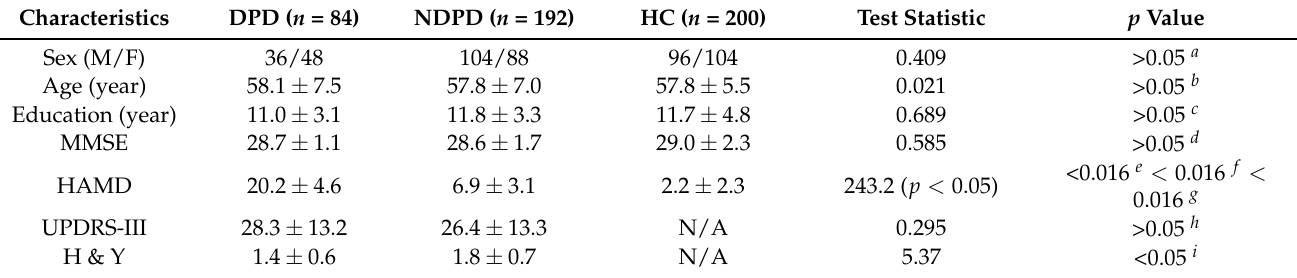
Table 1. Clinical and demographic data evaluation of NDPD, DPD, and HC. a . The p value for gender distribution by Fisher’s exact test. b . The p value for age by multivariate analysis of variance (MANOVA). c . The p value for education by MANOVA. d . The F test statistic and the p value